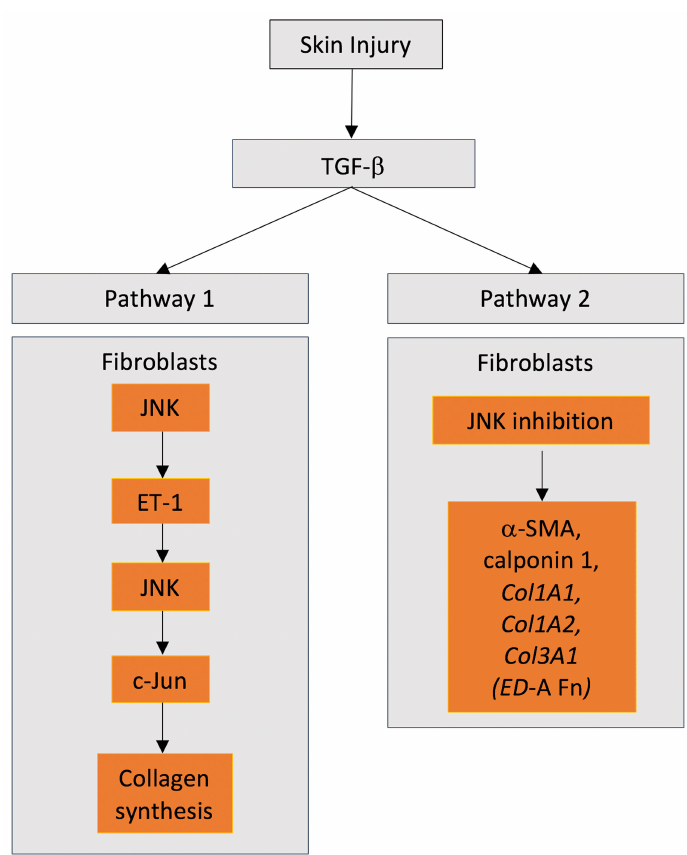
Figure 3. Conflicting role of JNKs in dermal fibroblast biology. JNK activation (Pathway 1) and JNK inhibition (Pathway 2) have been described to induce di ff erentiation of fibroblast towards a contractile, matrix secreting myofibroblast